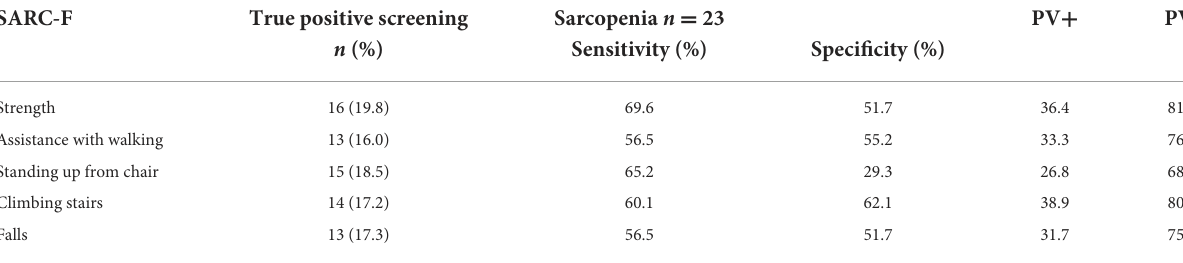
TABLE 5 Sensitivity of individual SARC-F items according to